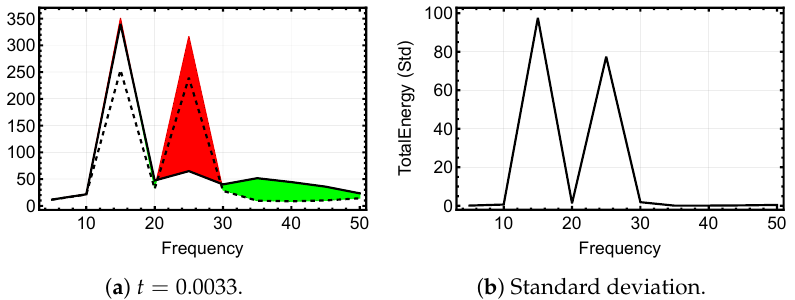
Figure 7. Concentrated load. Low-rank approximation results in a spurious peak at f = 25. Inter- estingly, at M = 6 for the dominant peak at f = 15, one standard deviation compensates for the difference between the full and low